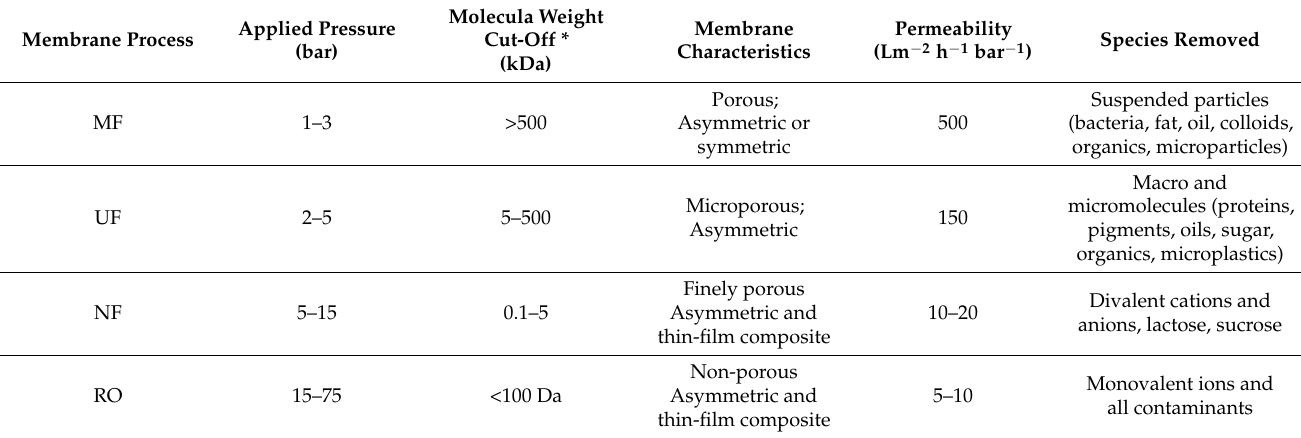
Table 2. Pressure-driven membrane processes. Adapted from [26].